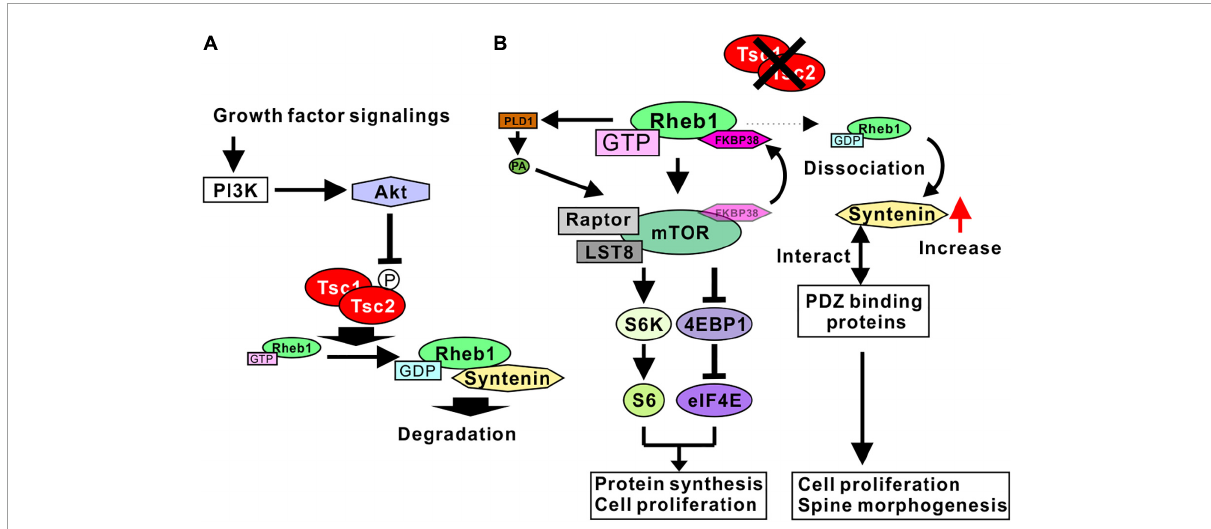
FIGURE1 Signaling pathways regulated by Tsc1/2. (A) Growth factor signaling activates Akt through PI3K. Active Akt phosphorylates Tsc2, leading to the inhibition of TSC1/2 GAP activity. Tsc1/2 act as GAP proteins of Rheb1. The GDP-bound form Rheb1 binds to syntenin and is degraded by proteosomes. (B) Tsc1/2 loss of function results in an increase in GTP-form Rheb1 (active Rheb1). Active Rheb1 induces the activation of the mTORC1 complex by sequestering FKBP38 and PLD1-mediated PA production. Active mTORC1 promotes protein synthesis and cell proliferation (left). Reduction of GDP-form Rheb1 resulted in a dissociation of syntenin from Rheb1 and an increase in free syntenin. Syntenin interacts with various types of PDZ domain-binding proteins, leading to cell proliferation and spine malformation